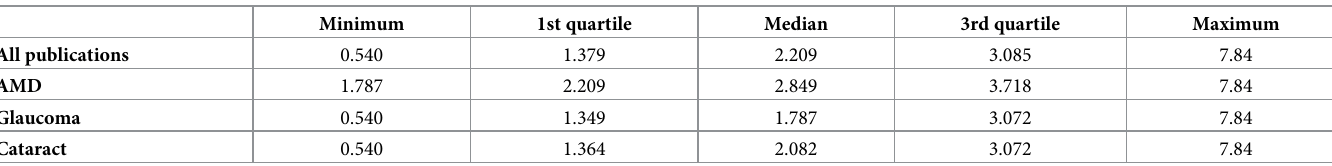
Table 4. Impact factor distribution.